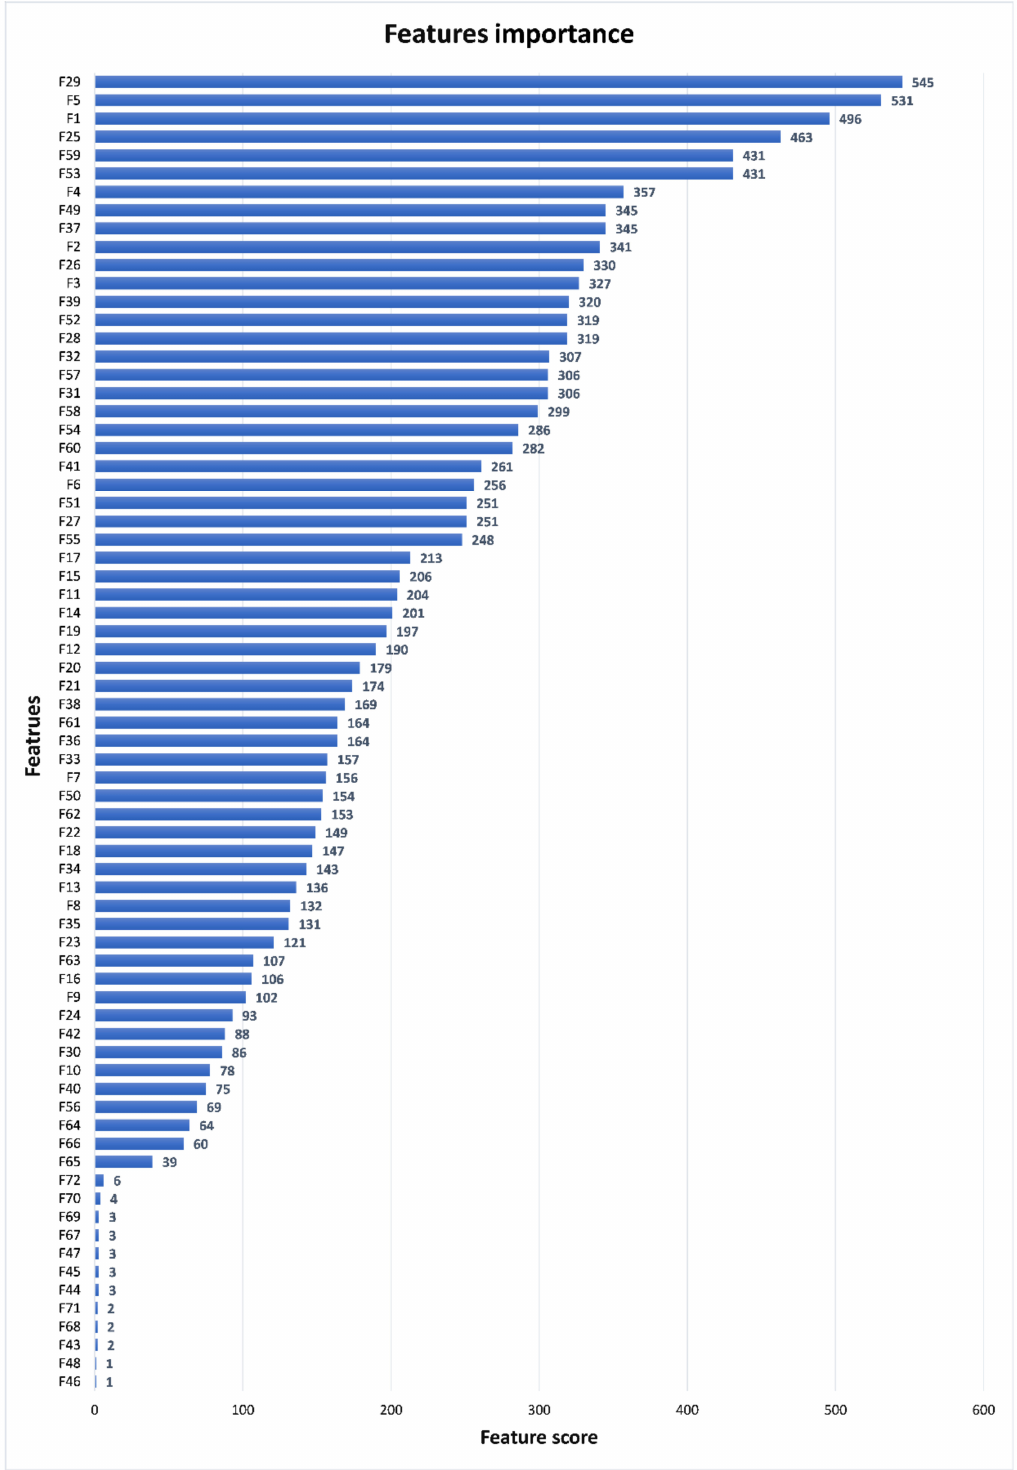
Figure 8. Feature importance